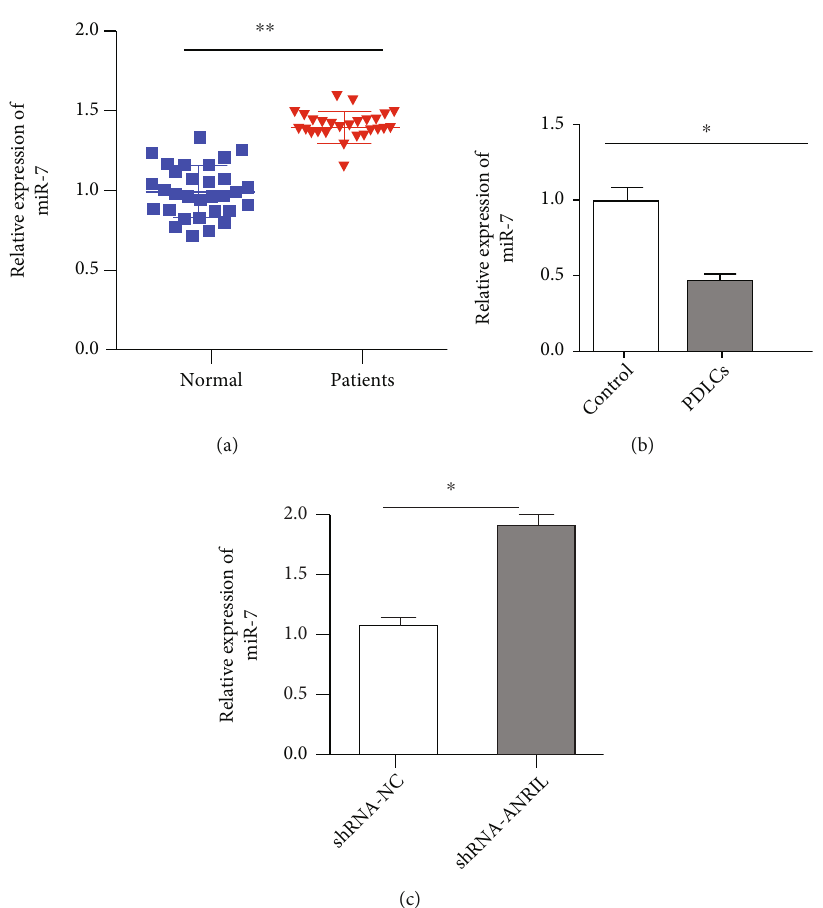
Figure 5: miR-7 expression in PDL tissues and PDLCs. (a) The level of miR-7 was tested in PDL tissues from periodontitis patients and healthy control by qPCR. (b) miR-7 level was detected by qPCR in undi ff erentiated and di ff erentiated PDLCs. (c) The expression of miR-7 was measured by qPCR after PDLCs were transfected with shRNA-NC and shRNA-ANRIL-2. ∗ P < 0 : 05 ; ∗∗ P < 0 : 01